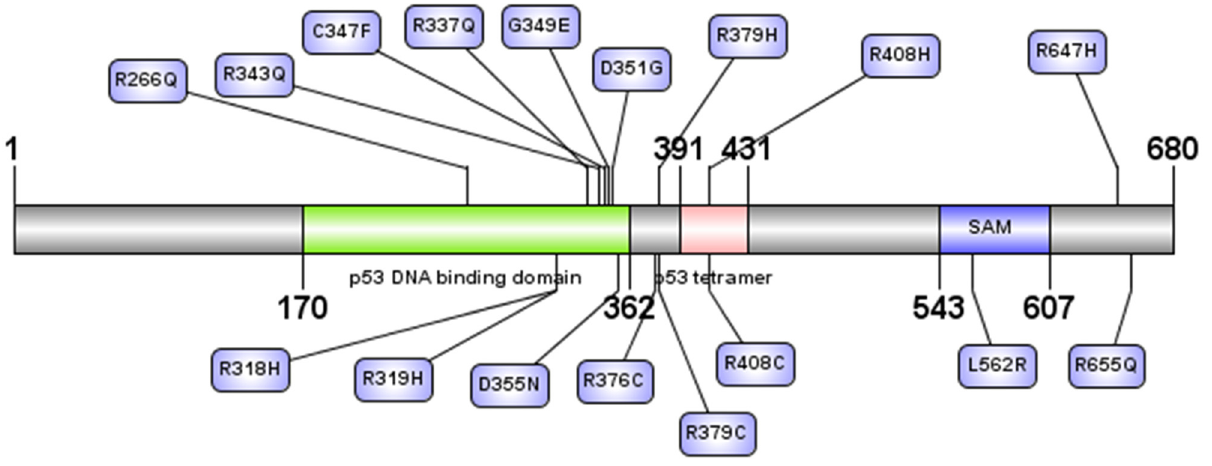
Figure 3. Seventeen nsSNPs that were predicted as deleterious are shown in the three principal domains of TP63 protein.